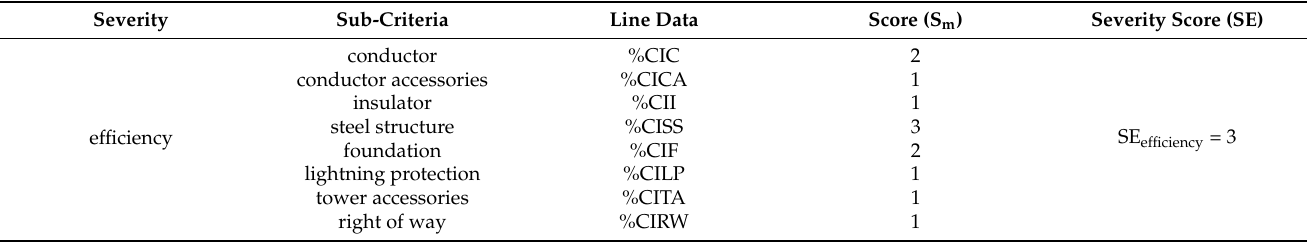
Table 10. Severity scores of the four criteria and sub-criteria of 230 kV tower no. 1, line no. 8.